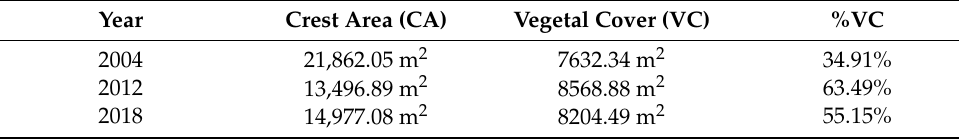
Table 1. Evolution of vegetation cover from 2004 to